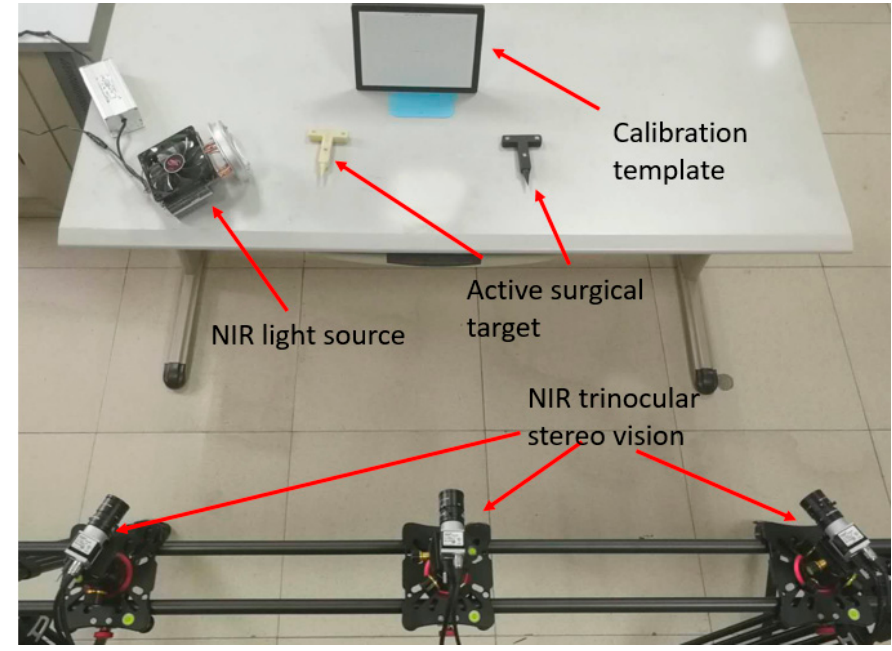
Figure 8. System setup.